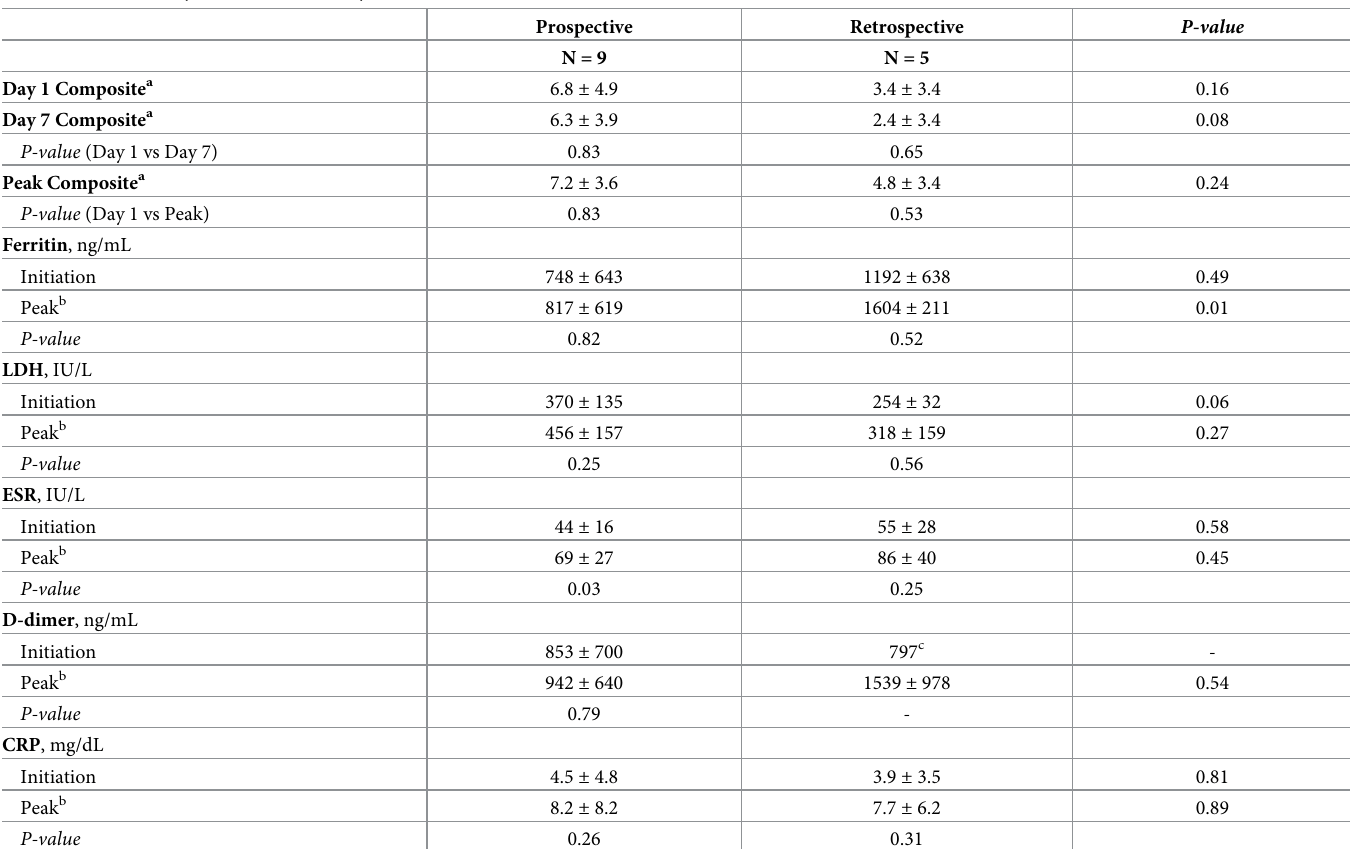
Table 5. Inflammatory markers in the study